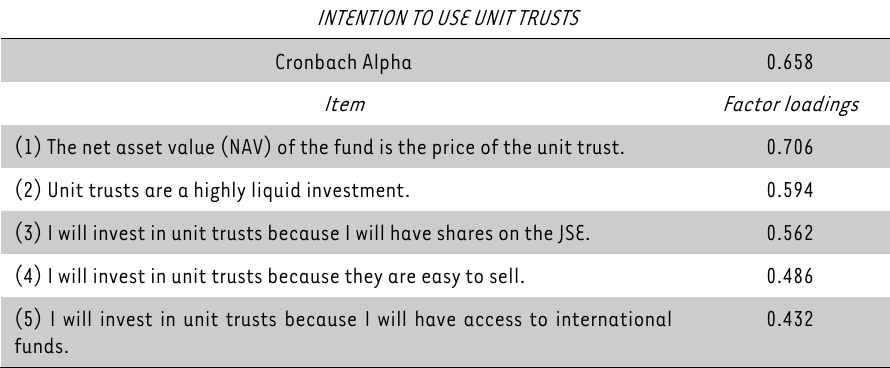
TABLE 3: Factor 3 - Intention to use unit